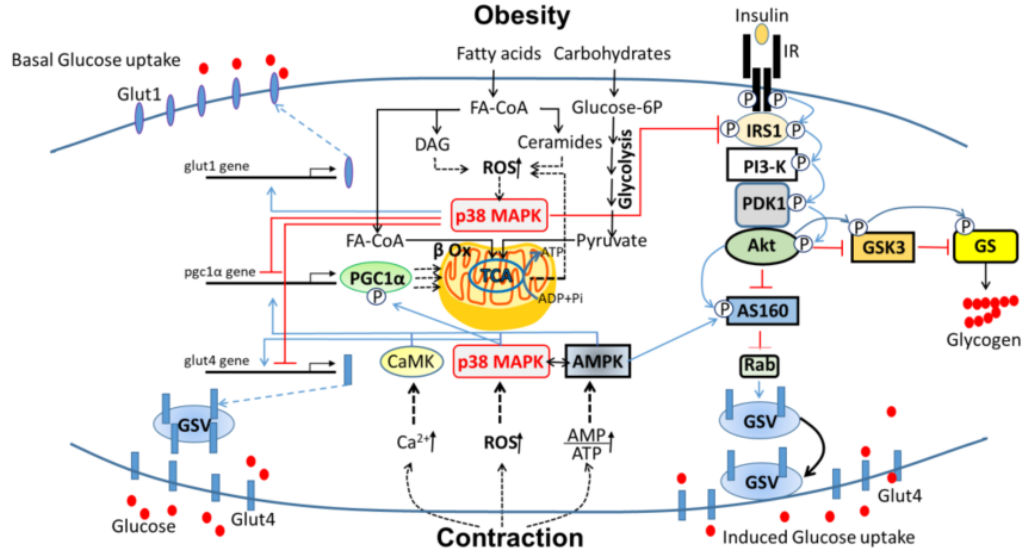
Figure 1. The involvement of p38 mitogen-activated protein kinase (MAPK) in glucose metabolism of skeletal muscle in health and disease. The upper half of the scheme describes the involvement of p38 MAPK in glucose metabolism of skeletal muscle in obesity: excessive intake of fatty acids and carbohydrates cause mitochondrial electron leak from the electron transport chain (ETC), accumulation of ROS, and mitochondrial dysfunction. Intramuscular fat metabolites (ceramide and DAG) reduce mitochondrial oxidative capacity and increase in the generation of mitochondrial reactive oxygen species (ROS) that induce p38 MAPK activity. Activated p38 MAPK inhibits IRS1 of insulin signaling through inhibitory phosphorylation. It also inhibits the transcription of Pgc1 α , Glut4 genes, and activates that of the Glut1 gene. As a result, insulin ‐ dependent glucose uptake is blocked, while insulin-independent glucose uptake is elevated. The lower half of the scheme describes the involvement of p38 MAPK in glucose metabolism of skeletal muscle in exercise: transient elevation in ROS induces the activity of p38 MAPK, which in turn stimulates the transcription of Pgc1 α and Glut4 genes. Besides, p38 phosphorylates PGC1 α and augments its activity needed for mitochondrial integrity and function. P38 MAPK synergizes with AMPK in glucose uptake; the first increases the levels of Glut4 and the second drives the transport of vesicular Glut4 to the plasma membrane. Abbreviations: GSV, Glut4 storage vesicles; DAG, diacylglycerol; PI3 ‐ K, Phosphoinositide 3 ‐ kinase; PDK1, Phosphoinositide-dependent protein kinase ‐ 1; GSK3, Glycogen synthase kinase 3; GS, Glycogen synthase; IR, Insulin receptor; FA, Fatty acid.